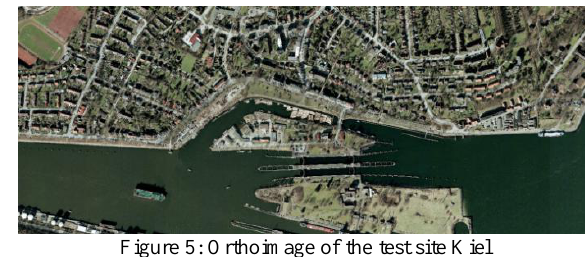
Figure 5: Orthoimage of the test site Kiel